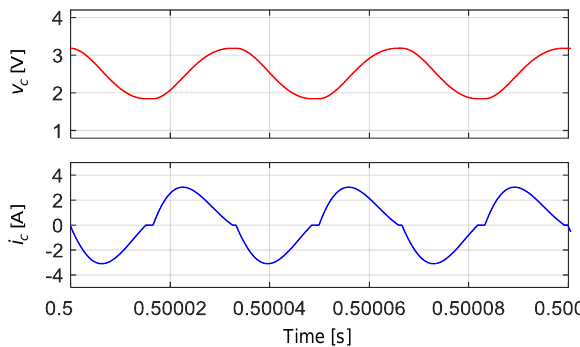
Figure 8. Zoomed waveforms of the switched-capacitor voltage and current at about t = 0.5.